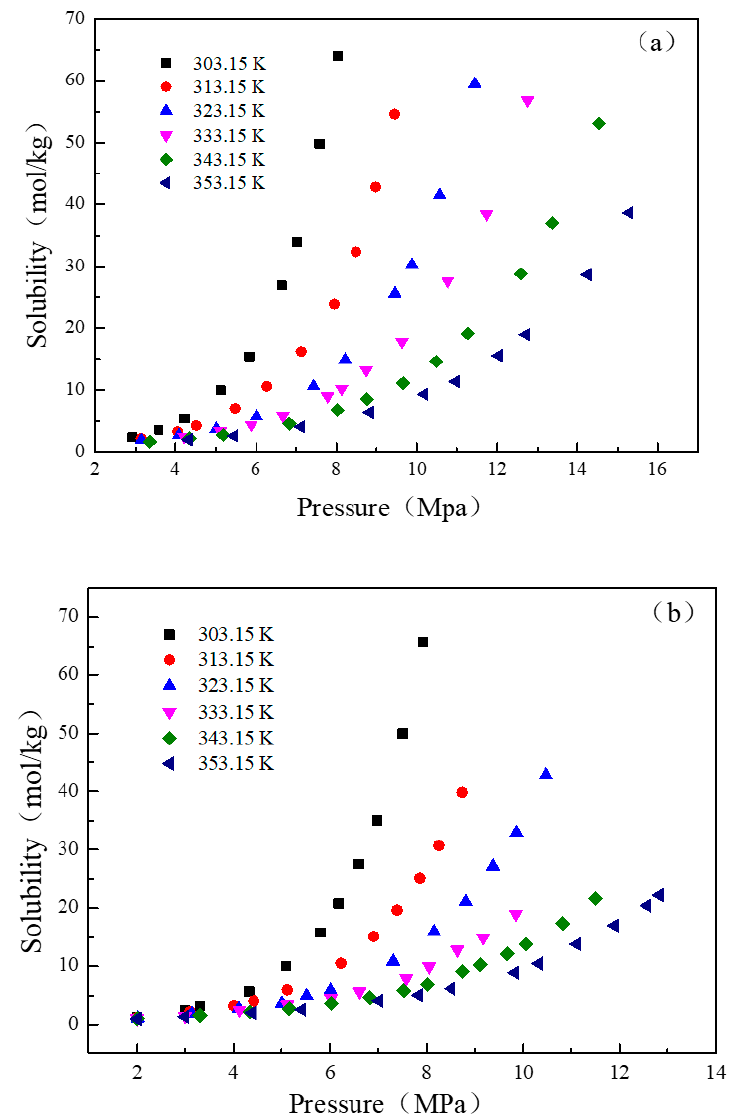
Figure 5. ( a ) The solubility of CO 2 + n − decane system at 303.15~353.15 K and 0~15 MPa; ( b ) The solubility of CO 2 + n − decane + n − hexane system at 303.15~353.15 K and 0~15 Mpa .